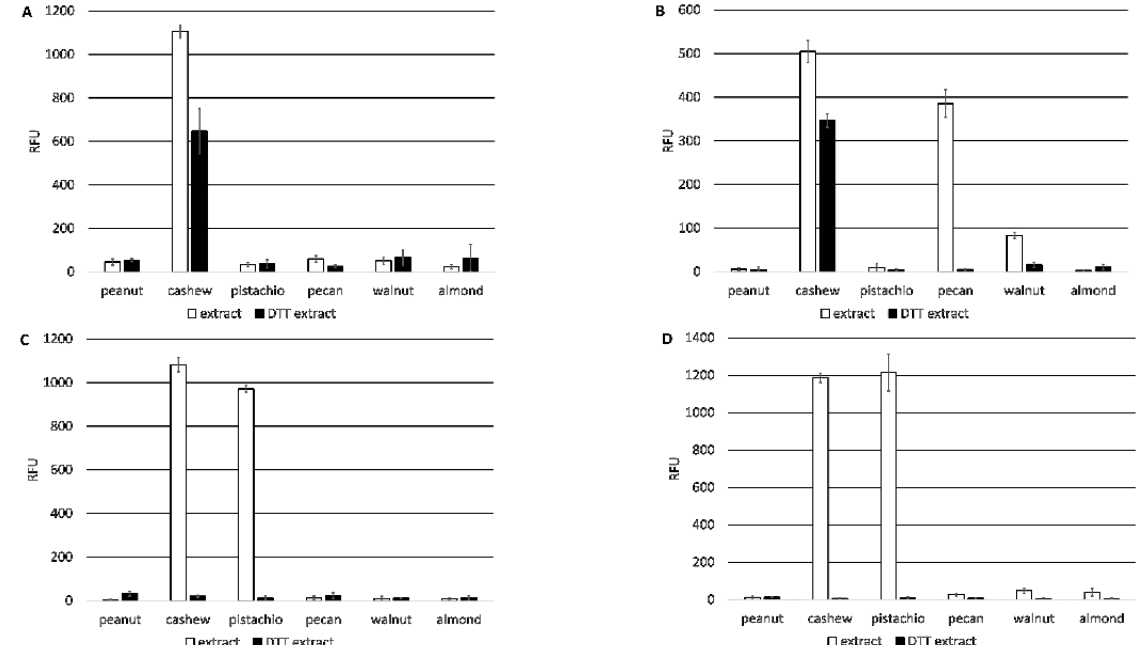
Figure 2. Specificity of anti-Ana o 3 monoclonal antibody binding to native or DTT treated peanut, cashew, pistachio, pecan, walnut, and almond nut extracts. Relative fluorescence units (RFU) are indicated on the y -axis. Data represent the average of at least four independent samples, and error bars included show ± standard deviation. Graphs represent ELISA values for ( A ) 2H5, ( B ) 5B7F8, ( C ) 6B9C1, and ( D ) 19C9A2 monoclonal antibodies.